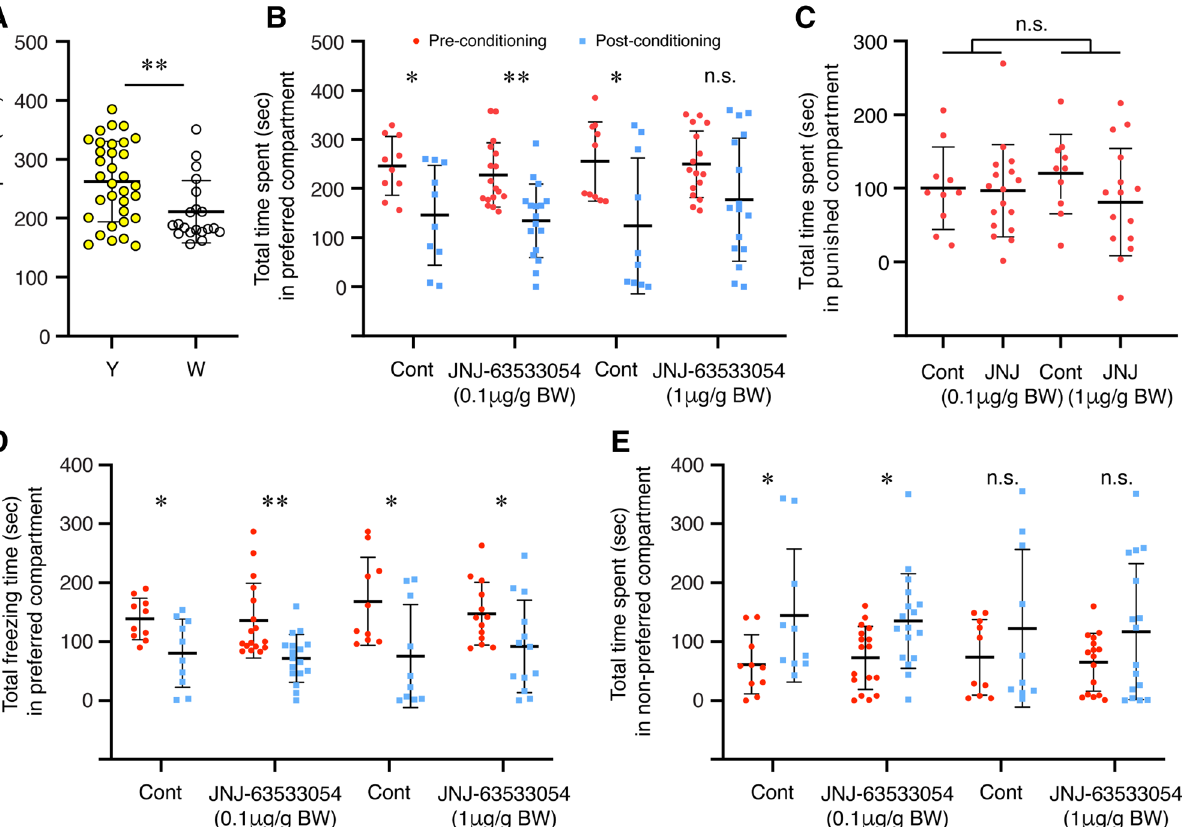
Figure 5. Effect of GPR139 agonist on fear memory recall and avoidance. ( A ) During pre-conditioning, fish were given a choice for their preferred colour, either yellow (Y) or white (W) coloured compartment. In total, a significantly higher number of fish preferred yellow coloured compartment during the pre-conditioning ( P = 0.006). After conditioning to alarm substance (AS)-induced fear-like responses, the fish were administered with GPR139 agonist (JNJ-63533054, either 0.1 or 1 µg/g body weight, BW), and the following day (Day-3), their preference was assessed based on their total time spent in either AS-paired (originally preferred) or water- paired (originally non-preferred) compartment. ( B ) During the post-conditioning, the time spent in AS-paired compartment (blue dots) was significantly reduced in both controls ( P = 0.0147 and P = 0.0185) and fish treated with 0.1 µg/g BW of GPR139 agonist ( P = 0.0005) as compared to pre-conditioning period (red dots), indicating successful development of conditioned place avoidance. On the other hand, in fish treated with the higher dose (1 µg/g BW) of GPR139 agonist, there was no difference in the time spent in the preferred compartment between pre-conditioning and post-conditioning phase ( P = 0.0519). ( C ) There was no dose-dependency in place avoidance ( P = 0.8403). ( D ) During the post-conditioning period, the total time frozen in the AS-paired compartment was significantly reduced in all groups [controls (0.2% DMSO, P = 0.0143; 2% DMSO, P = 0.0197), 0.1 µg/g BW GPR139 agonist ( P = 0.0013), 1 µg/g BW GPR139 agonist ( P = 0.0459)]. ( E ) On the other hand, the time spent in the water-paired unpunished compartment (originally non-preferred compartment) was increased during the post-conditioned phase in control (0.2% DMSO, P = 0.0483, Cohen’s d = 0.9472) and the fish treated with 0.1 µg/g BW GPR139 agonist ( P = 0.0118, Cohen’s d = 0.9155). However, in control (2% DMSO) and the fish treated with 1 µg/g BW GPR139 agonist, there was no significant change in the time spent in the water- paired unpunished compartment after the fear conditioning (control, P = 0.3086, Cohen’s d = 0.4686; 1 µg/g BW GPR139 agonist, P = 0.1072, Cohen’s d = 0.5877). *, P < 0.05; **, P < 0.01; n.s., no significant